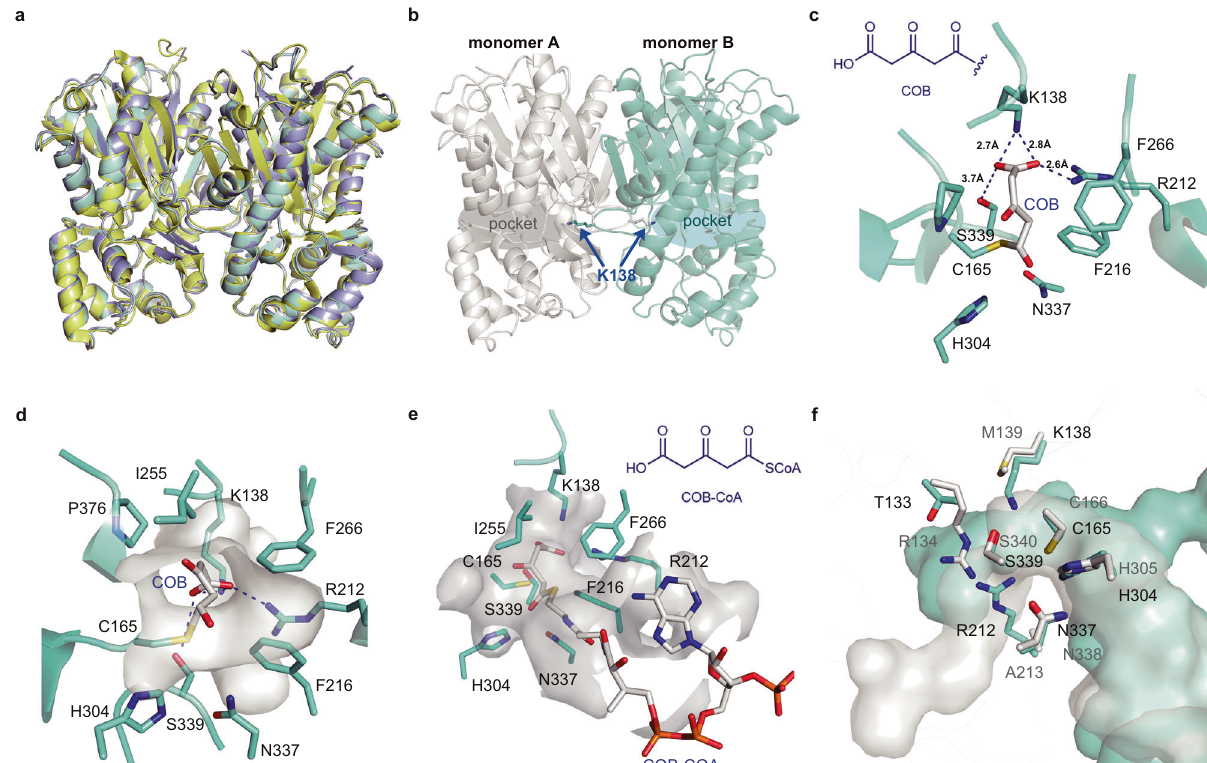
Fig. 3 | Crystal structures of En PKS1 and En PKS2. a Superposition of the En PKS1 (purple), En PKS2(cyan),and Aa PYKS1(yellow;PDBID:6J1M)structures. b Structure of En PKS2.K138fromanothermonomerparticipatesinformingtheactivecatalytic center. c , d Molecular docking of the COB intermediate with En PKS2. The En PKS2 catalytic pocket surface is colored in white. e Molecular docking of the COB-CoA